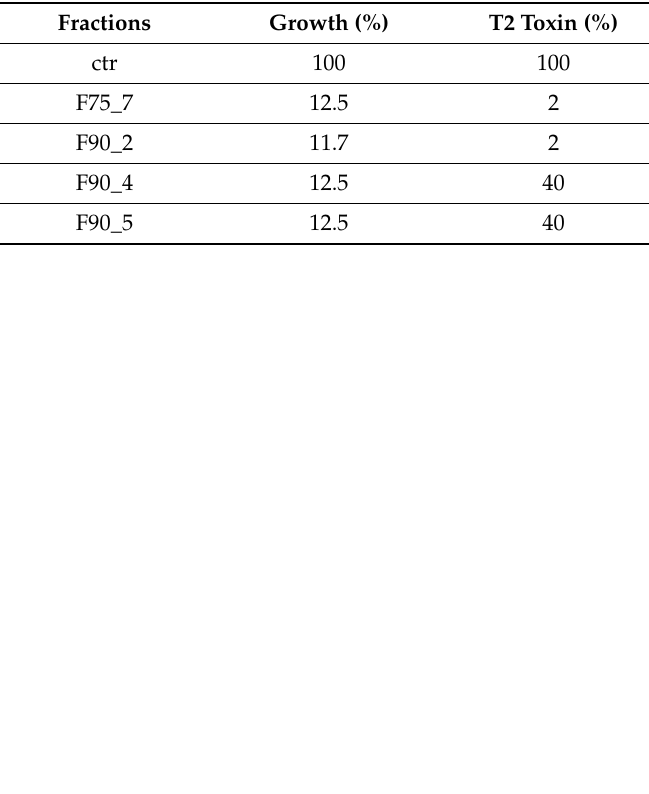
Table 1. Fungal growth and T2 toxin production by F. langsethiae non treated (ctr) and treated